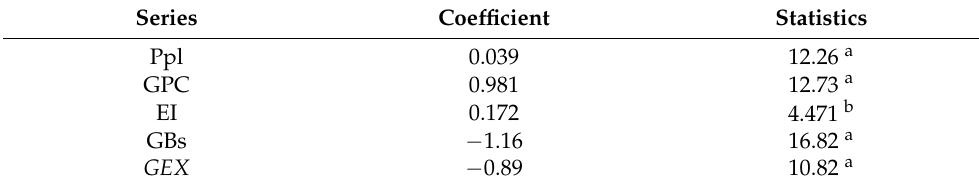
Table 8. AMG estimation